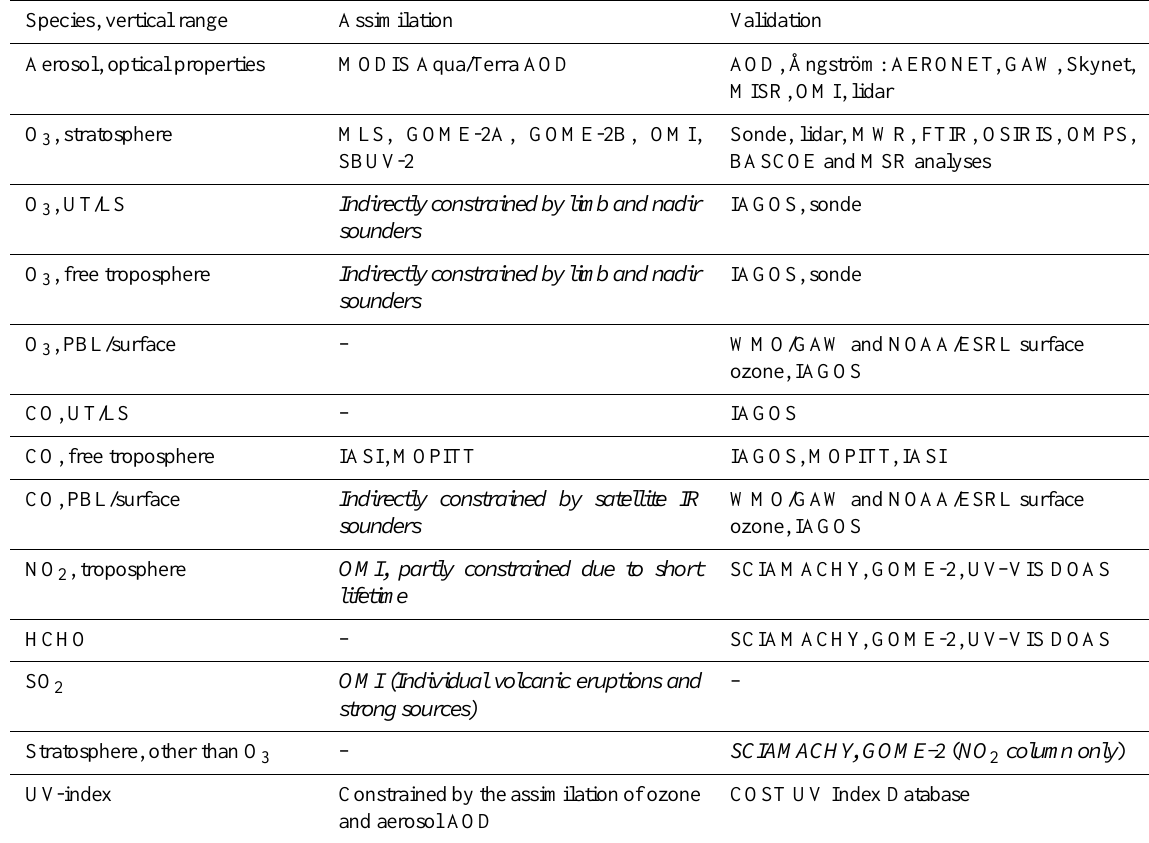
Table 1. Overview of the trace gas species and aerosol quantities relevant for the real-time global atmospheric composition service. Shown are the data sets assimilated (second column) and the data sets used for validation (third column). Normal text indicates that substantial data are available to either constrain the species in the analysis, or substantial data are available to assess the quality of the analysis. Italic text indicates that measurements are available, but that the impact on the analysis is not very strong or indirect (second column), or that only certain aspects are validated (third